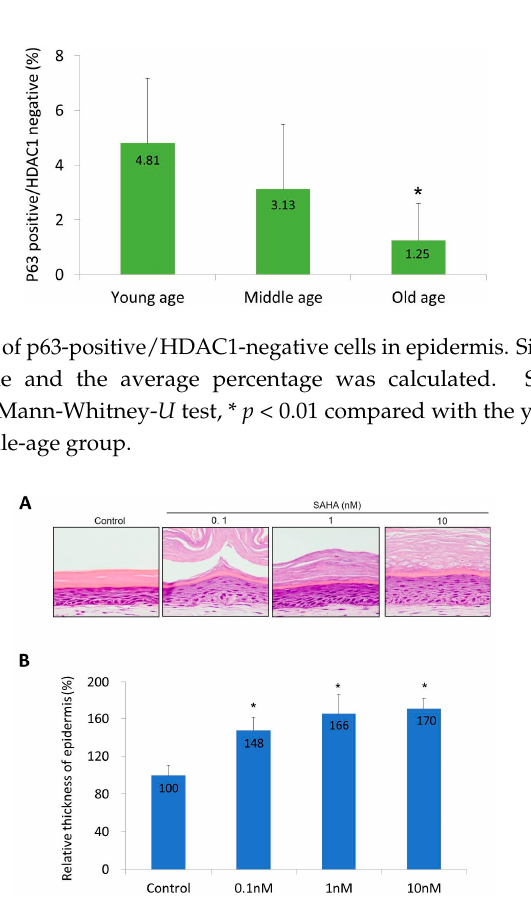
Figure 3. The change of epidermis after SAHA treatment in skin equivalent (SE). ( A ) H&E staining of SE; ( B ) The relative thickness of epidermis. Eight areas were randomly selected in each dose and the average relative thickness was calculated. Statistical significance was calculated with the Mann-Whitney- U test, * p < 0.01 compared with the control. This experiment was repeated twice and representative areas are shown.